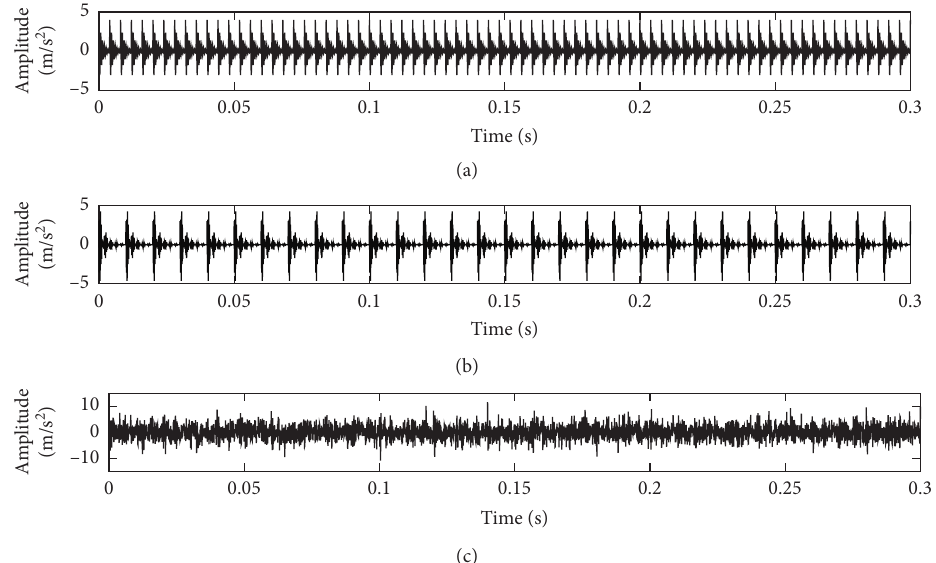
Figure 5: (a) The simulation signal of the faulty outer race. (b) The simulation signal of faulty rolling elements. (c) The mixed-signal includes (a) (b) and Gaussian noises.